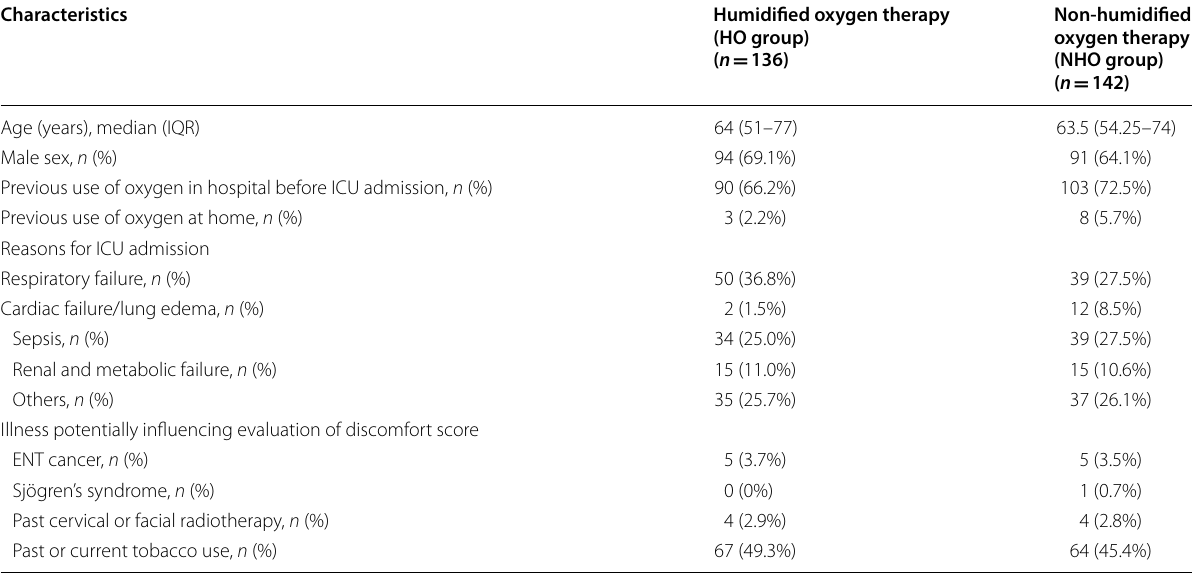
ENT ear, nose and throat, HO humidified oxygen, NHO non-humidified oxygen